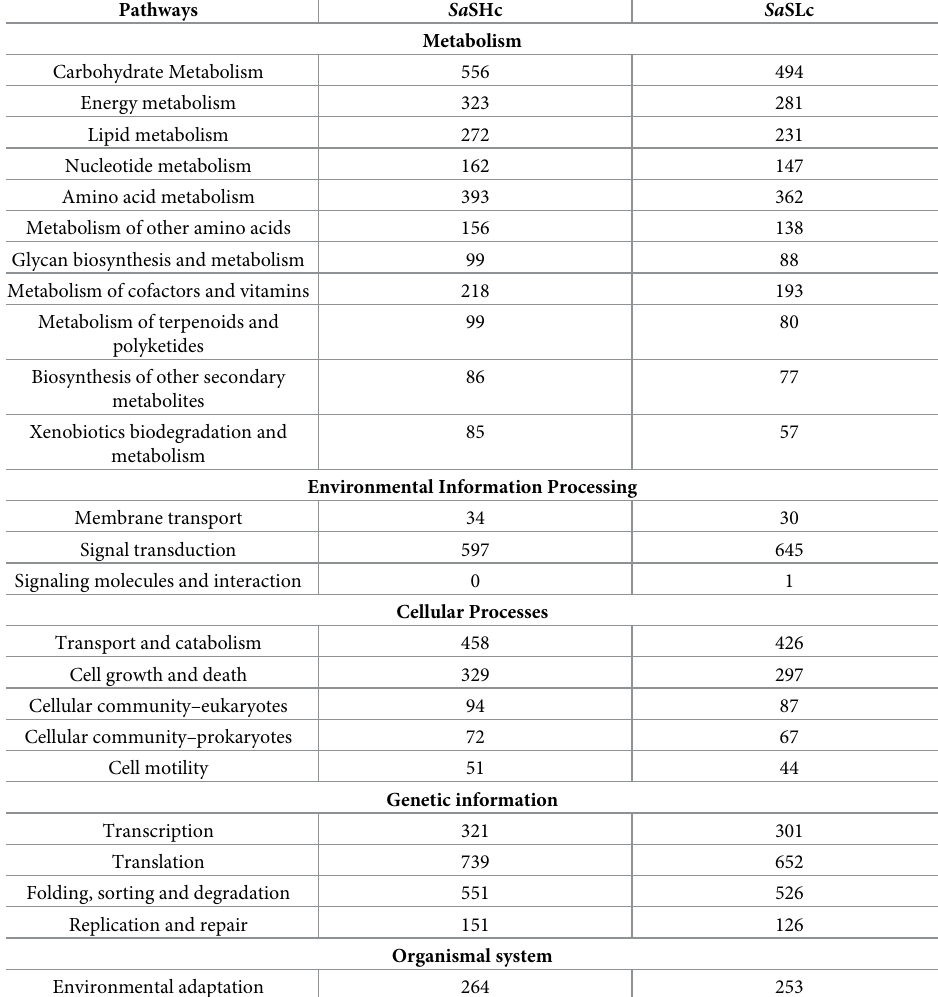
Table 3. Comparative KEGG pathway classification of coding sequences in high oil ( Sa SHc) and low oil ( Sa SLc) yielding S . album .